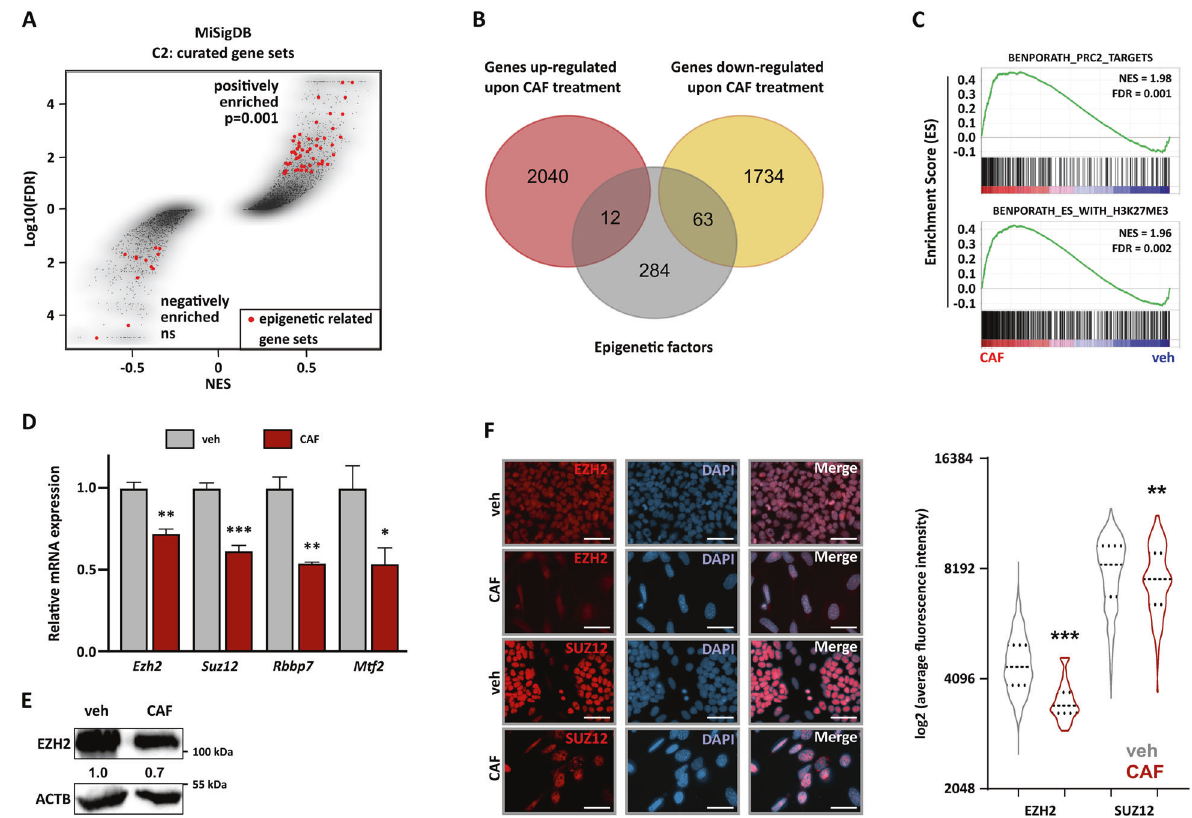
Fig. 2 WAP-T tumor cells surviving CAF treatment downregulate the expression of PRC2 core subunits. A GSEA analysis results (MiSigDB C2: curated gene sets) plotted as an overview along with Normalized Enrichment Score (NES) and log10(FDR). The red dots represent signi fi cantly enriched epigenetic-related gene sets. A signi fi cant positive enrichment of gene signatures associated with epigenetic mechanisms perturbation was identi fi ed. B Identi fi cation of differentially regulated epigenetic factors: genes regulated in pG-2 cells upon survival to CAF treatment (|Log2(Fold Change)| > 0.7, p -adj < 0.05) were intersected with a list of known epigenetic factors. No signi fi cant enrichment of epigenetic factors was observed in the groups of up or down-regulated genes, as assessed by Fisher ’ s exact test. C Representative GSEA enrichment plots showing the enrichment of gene signatures typically repressed by PRC2 in CAF-treated pG-2 cells. D Validation of Ezh2 , Suz12 , Rbbp7 , and Mtf2 expression changes via qRT-PCR. Data were calibrated on the control condition and normalized to the Rplp0 housekeeping gene expression. E Reduction of EZH2 protein levels upon CAF treatment assessed via western blot. F Immuno fl uorescence staining showing a reduction of EZH2 and SUZ12 levels upon CAF treatment of pG-2 cells (scale bars = 50 µm). A quanti fi cation of EZH2 and SUZ12 signals is provided in the right panel. Error bars: standard error of the mean (SEM). * p -val ≤ 0.05, ** p -val ≤ 0.01, *** p -val ≤ 0.005. Statistical tests: Fisher exact test ( A ), Student ’ s t -test ( D ), Mann-Whitney test ( F: violin plot). All experiments were performed in biological triplicates ( n =